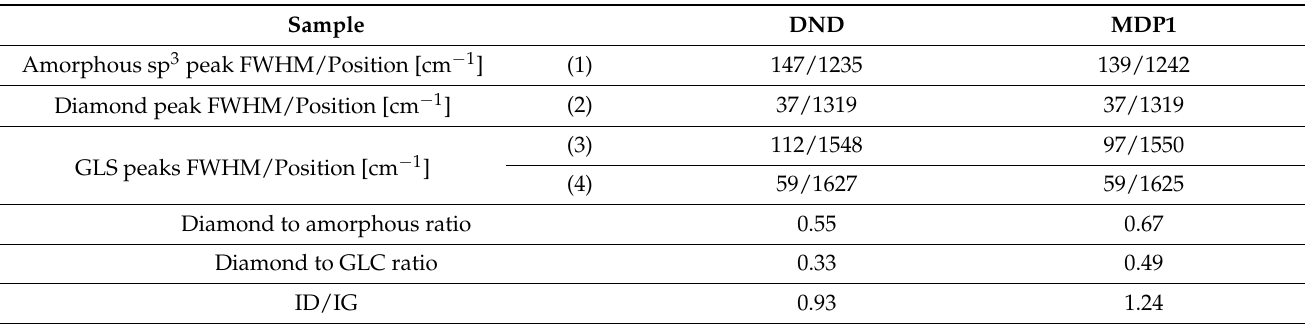
Table 3. Analysis of the Raman spectra.